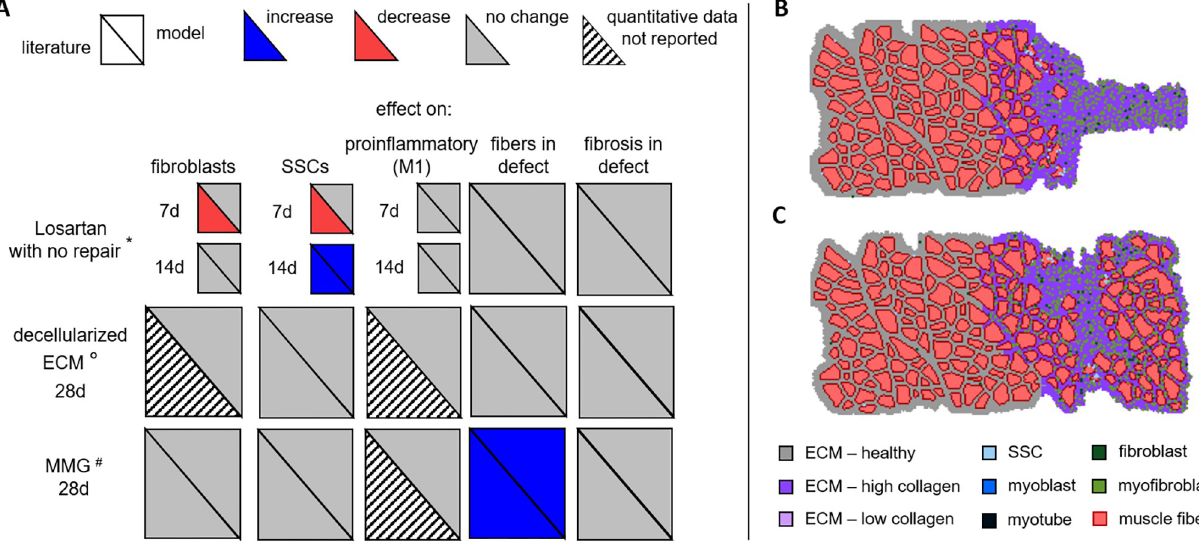
Fig 5. ABM predictions of cell behaviors, muscle fiber, and ECM changes 7, 14, and 28 days after injury and treatment were compared with published experimental results. Triangles represent an increase (blue), decrease (red), no change (grey), in response to the indicated treatment (i.e. Losartan with no repair, decellularized ECM, or MMG) or no quantified data available (striped) compared to VML injuries without repair (A). We compared quantitative changes in fibroblast, SSC, and pro-inflammatory macrophage numbers and compared qualitative changes in fibers and fibrosis in the VML defect. We also simulated VML injury treatments published in the literature and compared our model predictions to independent experimental results published in the literature: � [23], ˚ [11,13], # [9,13,35].Graphical ABM outputs at 28 days showed that treating the VML injury with decellularized ECM resulted in fibrotic tissue (i.e. increased collagen) filling the defect (B) and minced muscle graft (MMG) treatment resulted in muscle fibers present in the defect (C).